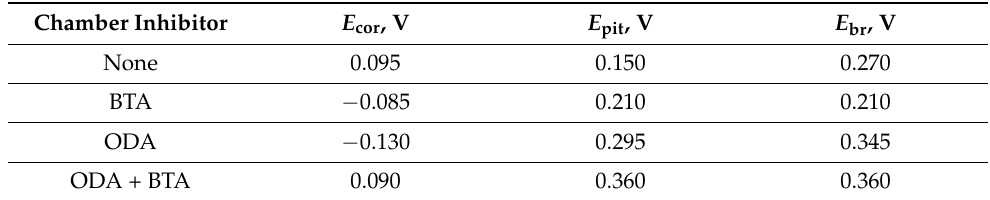
Table 3. Effect of steel CT on the characteristics of anodic potentiodynamic curves. T CT = 120 ◦ C, τ CT = 1 h.